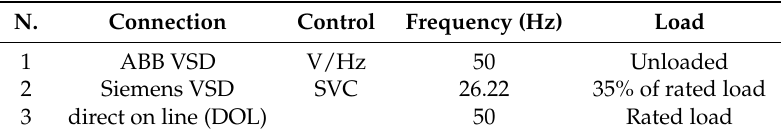
Table 1. Experimental